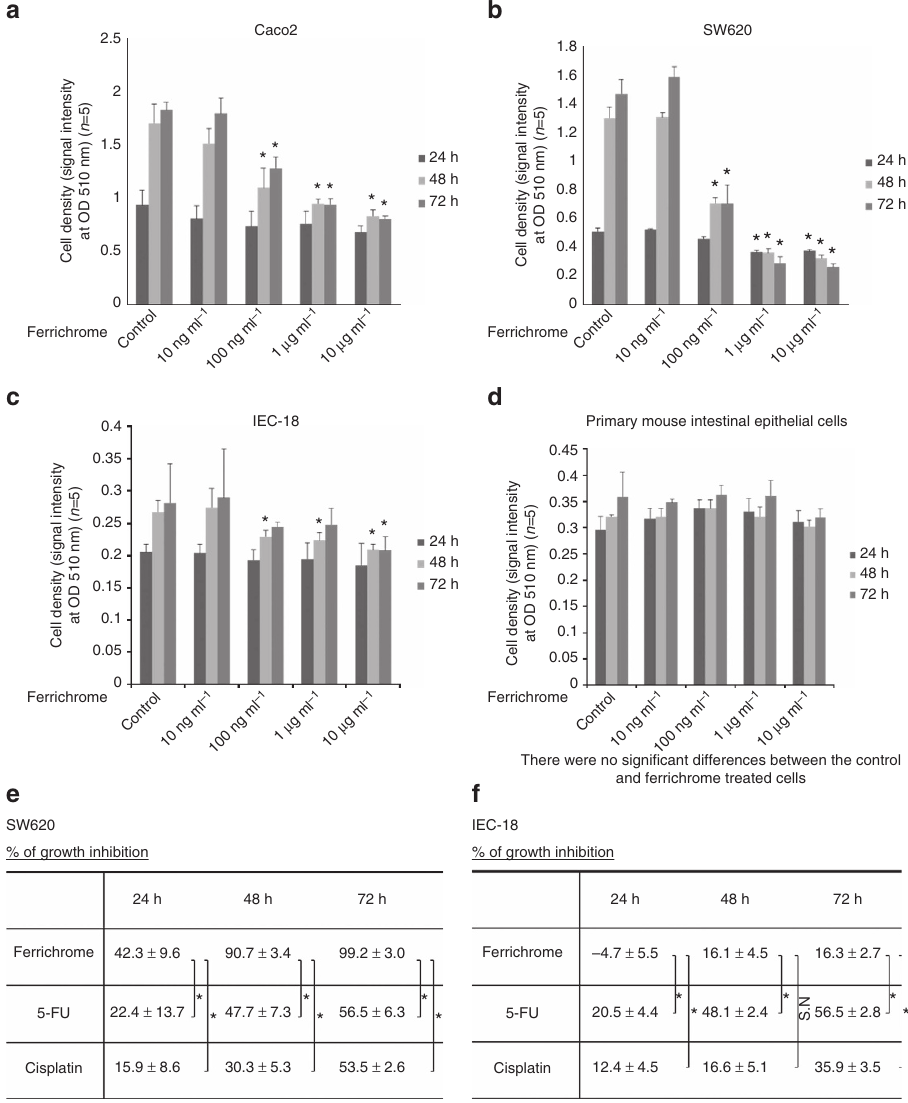
Figure 5 | Ferrichrome exhibited tumour-suppressive effects in colon cancer cells, but not in normal epithelial cells. Ferrichrome reduced cellular progression in a dose-dependent manner in Caco2/bbe ( a ) and SW620 cells ( b ). Ferrichrome did not affect the cell growth of IEC-18 cells ( c ) or the primary cultures of intestinal cells ( d ). 5-FU and cisplatin reduced the cell growth in SW620 ( e ) and IEC-18 cells ( f ). * P o 0.05 by Student’s t -test. The error bars show the s.d. ( n ¼